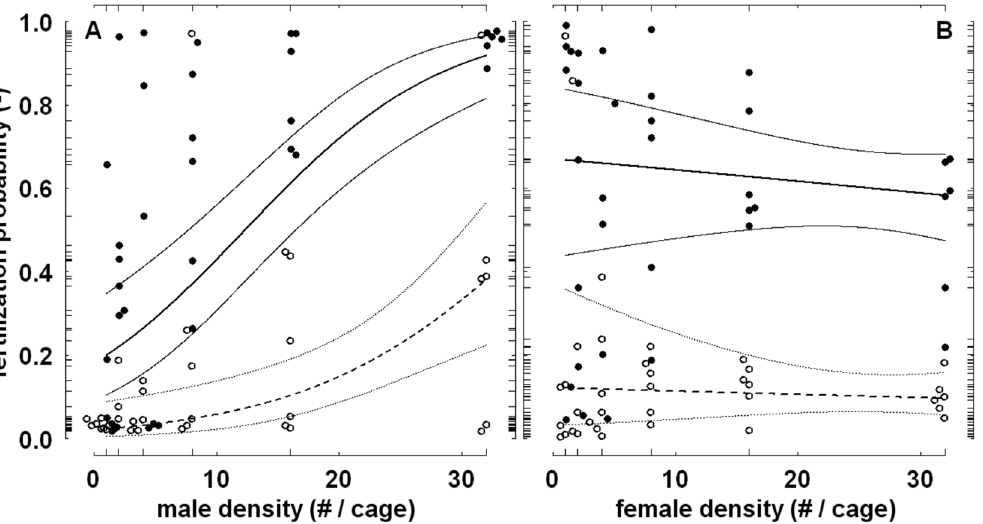
Figure 5. Fertilization probability in relation to male density (panel A) and female density (panel B). Presented are the back-transformed values of the ln-transformed odds (i.e. logits) of fertilization of a female Leptinotarsa decemlineata . To avoid taking the natural logarithm of 0, the smallest proportion of fertilized or unfertilized females observed (i.e. 0.03) was added and subtracted to observations of 0 and 1, respectively. Open and filled symbols depict single observations from short trials and long trials, respectively, after variation accounted for by model terms other than the ones depicted in the panel at issue has been taken out. Superimposed are the back-transformed fitted linear regression lines based only on the model terms depicted in the panel at issue (thick lines), with dotted lines and solid lines presenting predictions for short trials and long trials, respectively. The back-transformed approximate 95% confidence intervals (Collett [38] 1 3.15) of the fitted models are indicated by thin lines. Long tick marks indicate treatment levels and response values. Bracketed information in the axis labels concerns the dimension of the variable at issue (‘ 2 ’ indicating dimensionless). For representational purposes, results of short trials and long trials, as well as results overlapping within trial duration, have been slightly shifted horizontally. Note that despite distortion, not all observations are visible at the lower densities. Also note the log-scale of the x- axis.